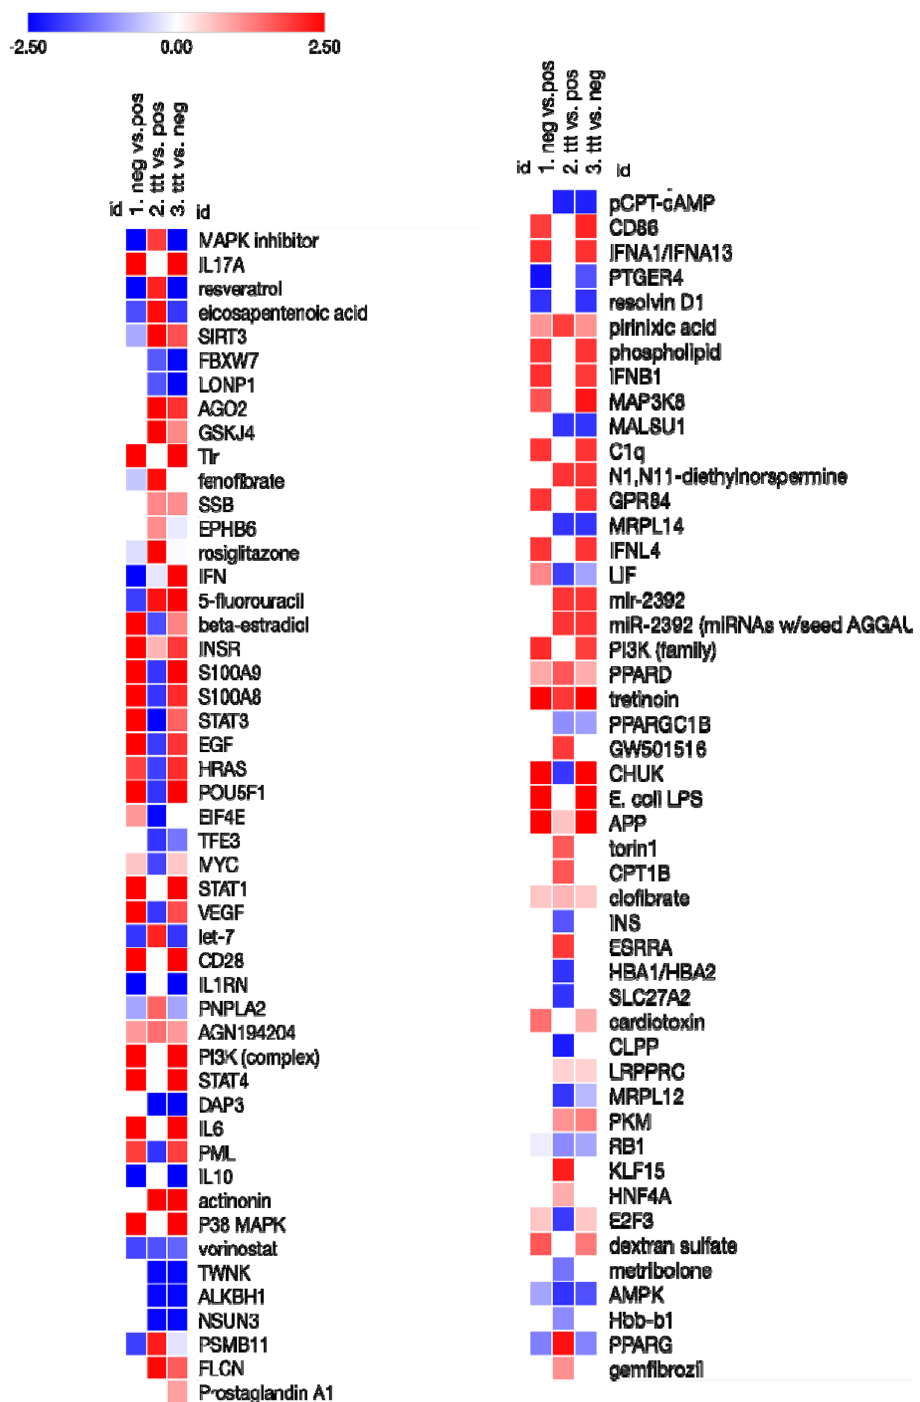
Figure 3. Heatmap of differentially expressed upstream regulators for comparison of RA patients. Data were analyzed through the use of IPA (Qiagen Inc., https:// www. qiage nbioi nform atics. com/ produ cts/ ingen uity- pathw ay- analy sis). IPA analysis of DEGs associated with upstream regulators that predicted activated state (red) and predicted inhibited state (blue) are shown. Data files were exported for those genes from IPA and reproduced heatmaps using Broad Morpheus software available at (https:// softw are. broad insti tute. org/ morph eus/). Relative expression heat maps of the differentially expressed regulators regulated by; (1) unstimulated (vehicle) vs LPS-stimulated monocytes (2) PNLA-treated LPS-stimulated vs vehicle-treated LPS-stimulated monocytes, and (3) PNLA-treated LPS-stimulated vs unstimulated (vehicle-treated) monocytes (Log2 FC > 1.2, p < 0.05) are shown. The regulators shown here are mainly involved in cytokine production, lipid and fatty acid metabolism, drugs used for treating hyperlipidaemia, miRNAs and transcription factors. LPS Lipopolysaccharide, PNLA pinolenic acid, ttt